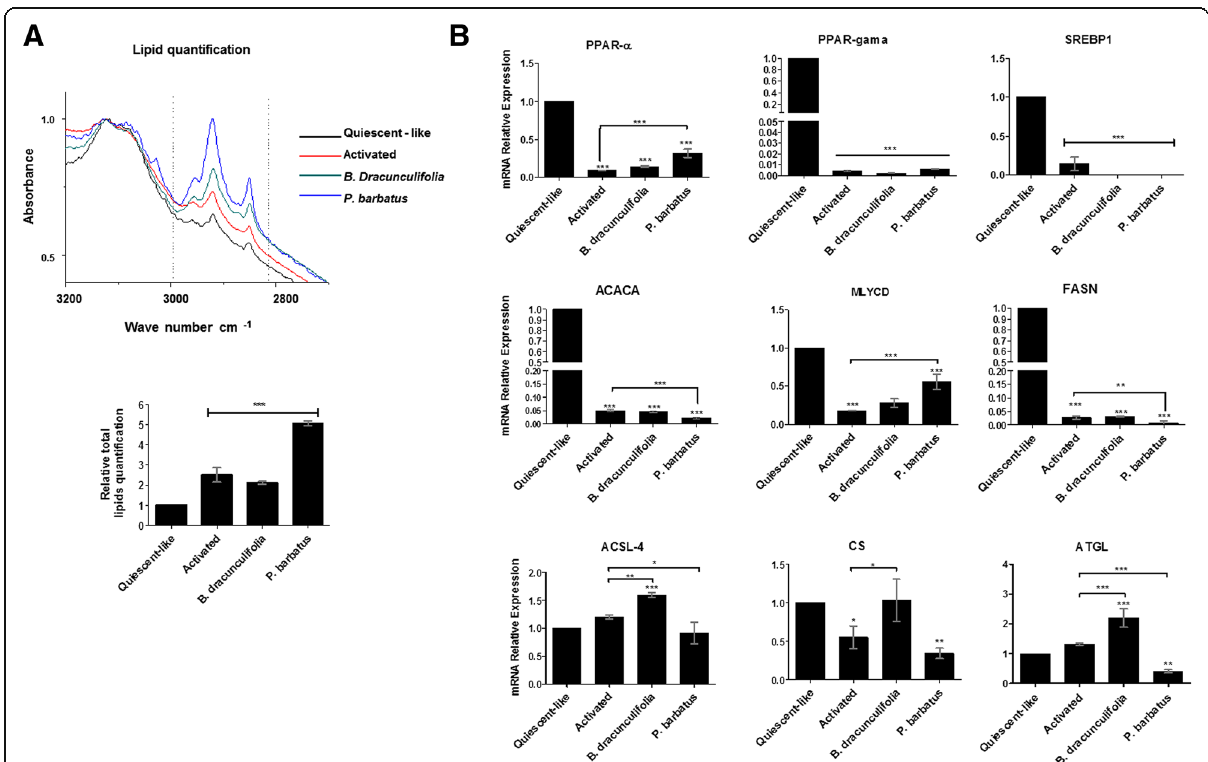
Fig. 4 Lipid metabolism in LX-2 treated with the medicinal plant extracts Baccharis dracunculifolia and Plectranthus barbatus . ( a ) Total lipid amounts in different groups of LX-2 ( b ) Transcriptional level of elements relevant to lipid metabolism in different groups of LX-2 cells by qRT-PCR. The graphs represent the mean values of at least three independent experiments ( p <